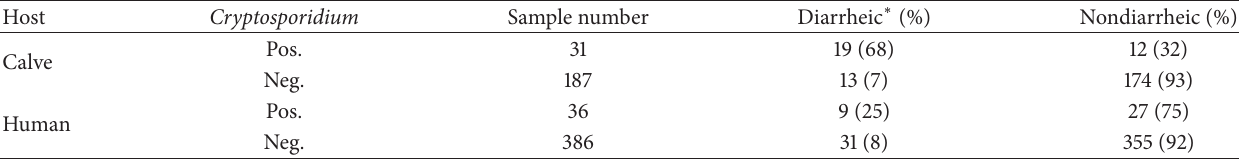
Table 2: Cryptosporidum prevalence in diarrheic and nondiarrheic calves and humans.